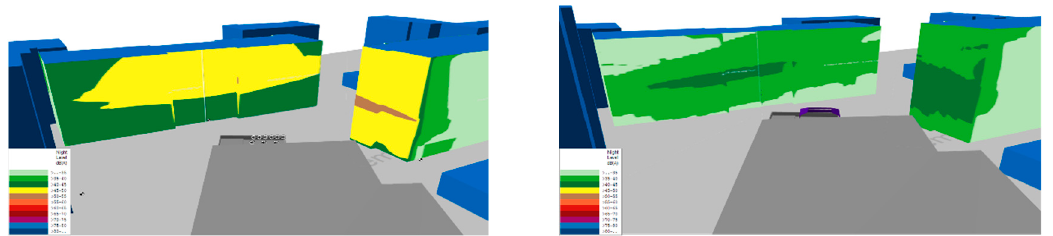
Figure 15. Ln—façade calculation plots ( left : Scenarios 1, 2, 3 and 4, right : Scenario 5).